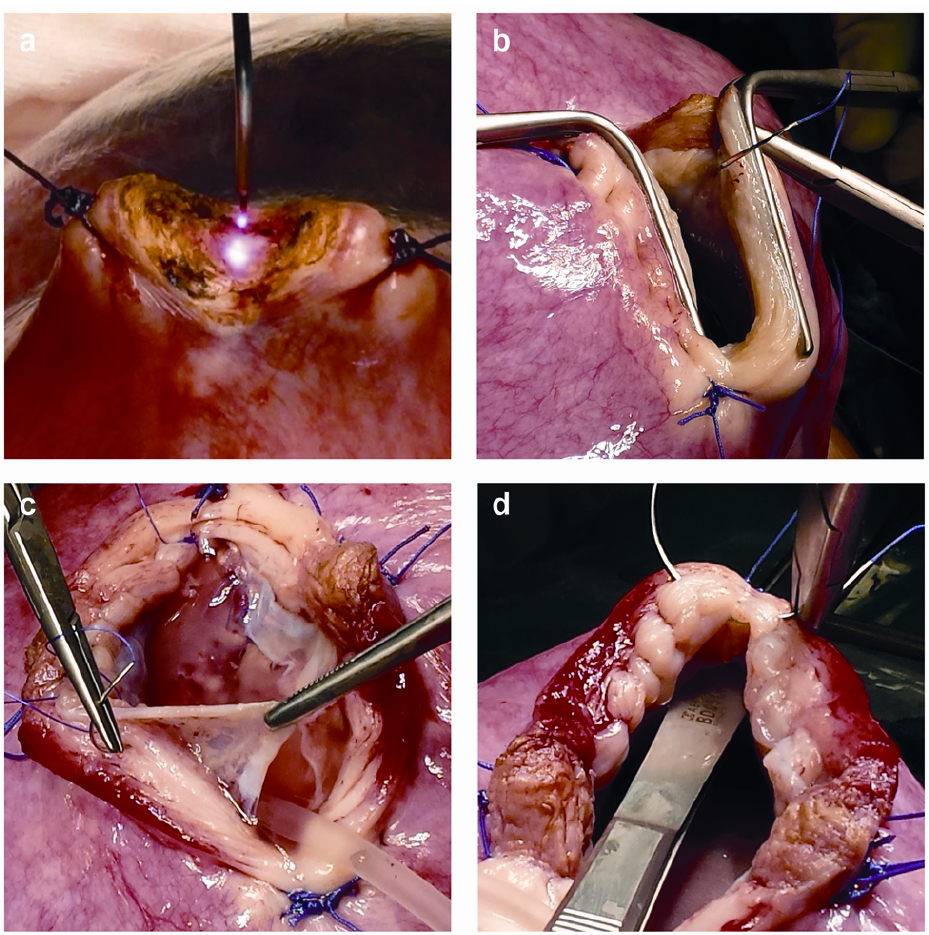
Figure 1. Technical details of intrauterine MMC repair (IUMR): ( a ) Initial opening of the uterus with a diode laser. ( b ) Placement of the DeBakey clamps in the line of the incision and fixation of the